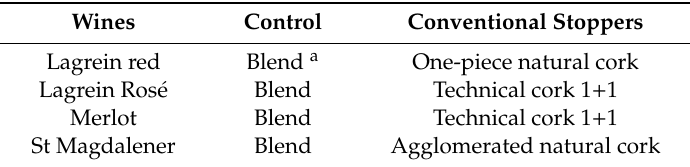
Table 6. Types of closures used for the wine bottles.